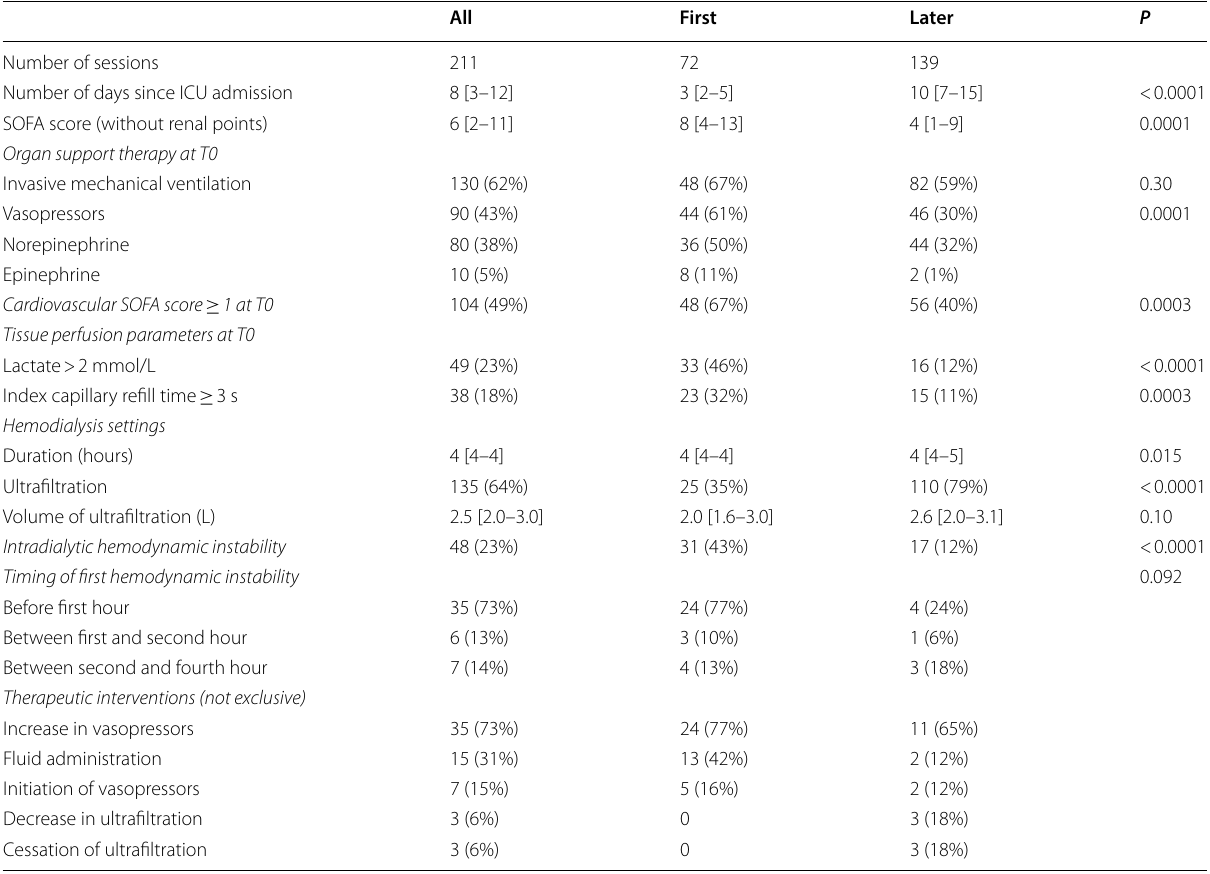
Table 2 Characteristics of intermittent hemodialysis sessions